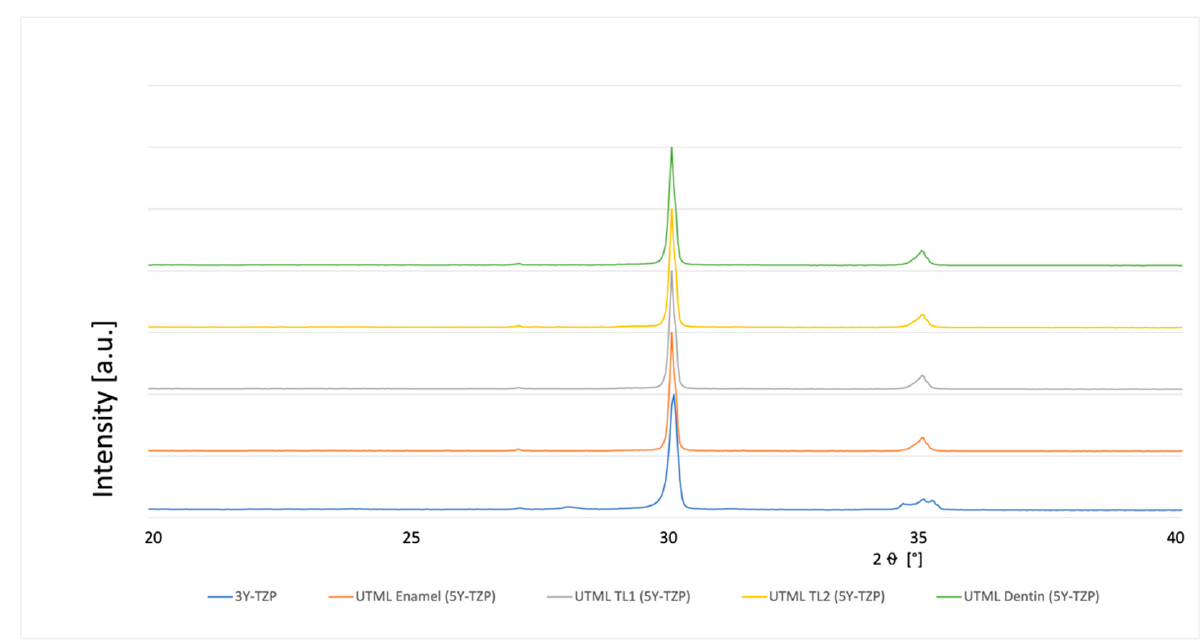
Figure 4. XRD analysis 3Y-TZP and 5Y-PSZ 1 µm polished and fully sintered before cutting.